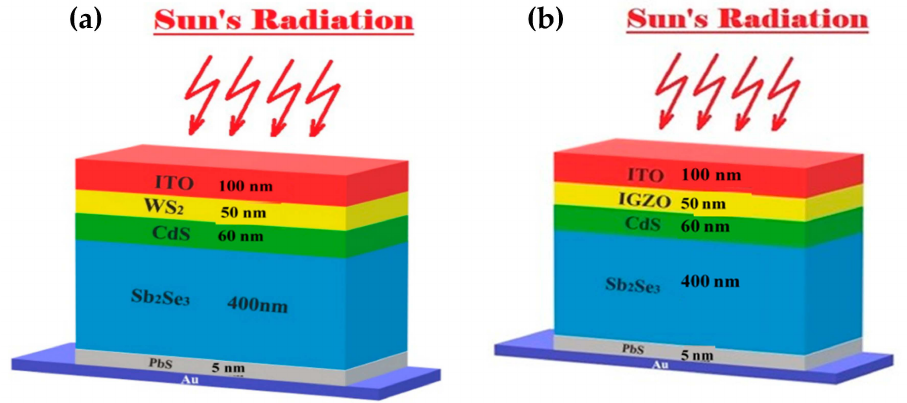
Figure 1. Schematic of the device structure of ( a ) WS 2 and ( b ) IGZO ETL-based